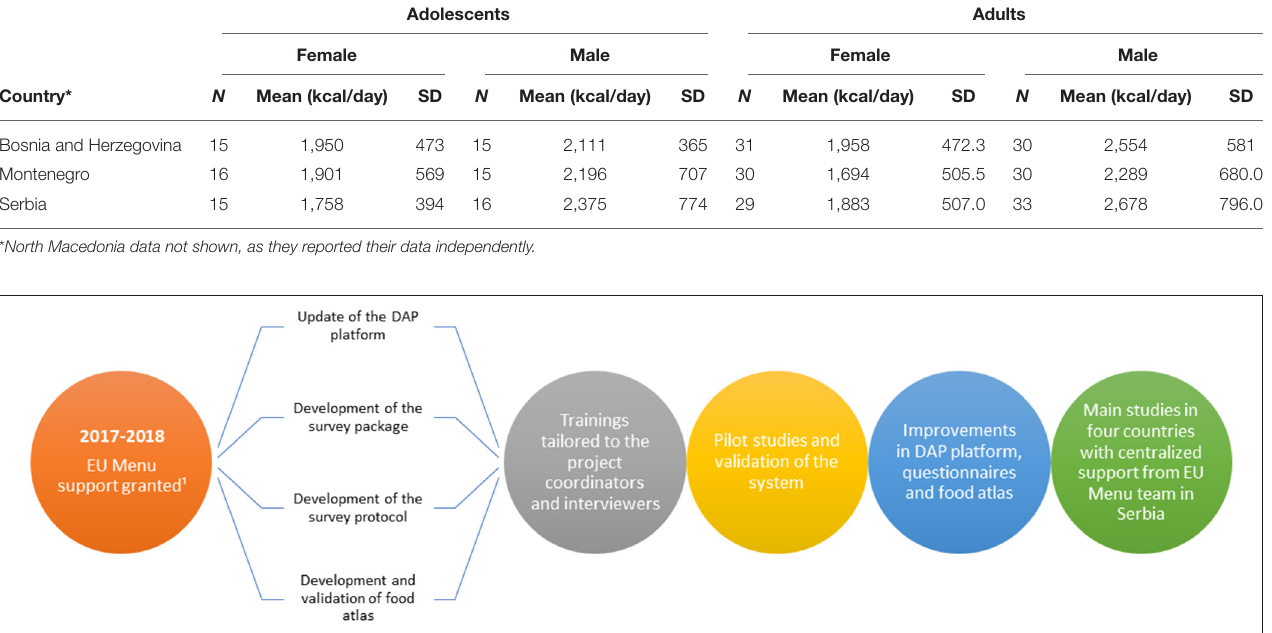
(ICN 2 FfA) in the recommendation No. 58, urges